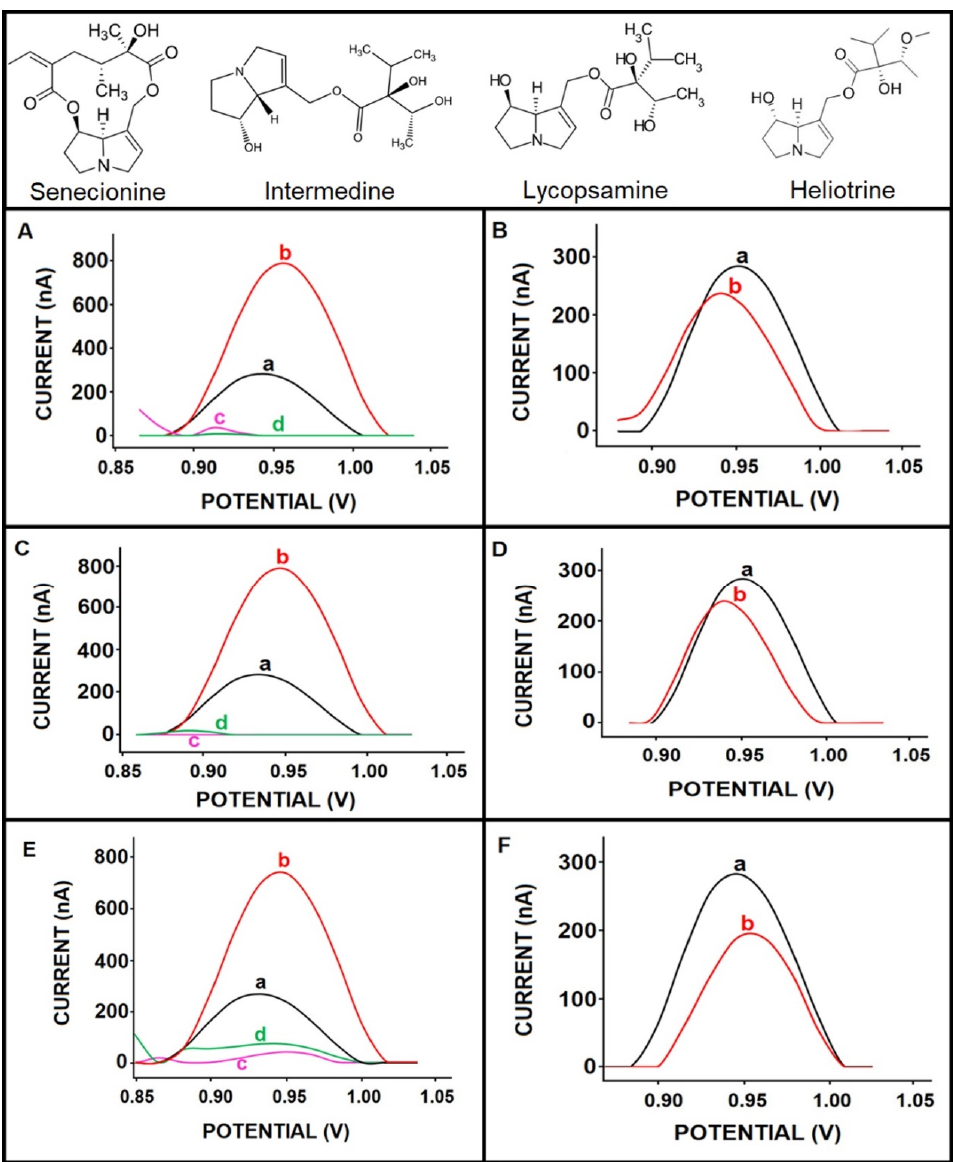
Figure 5. Voltammograms related to the selectivity of our assay in the presence of potential interferents individually ( A , C , E ) or in mixture samples ( B , D , F ) with the chemical structure of SEN and interferents. ( A ) The oxidation signal of (a) 25 µg/mL SEN, (b) 100 µg/mL SEN, (c) 25 µg/mL intermedine, (d) 100 µg/mL intermedine. ( B ) The oxidation signal of 25 µg/mL SEN (a) in the absence of intermedine and (b) in the presence of mixture sample containing 25 µg/mL SEN and 25 µg/mL intermedine. ( C ) The oxidation signal of (a) 25 µg/mL SEN, (b) 100 µg/mL SEN, (c) 25 µg/mL lycopsamine, (d) 100 µg/mL lycopsamine. ( D ) The oxidation signal of 25 µg/mL SEN (a) in the absence of lycopsamine and (b) in the presence of mixture sample containing 25 µg/mL SEN and 25 µg/mL lycopsamine. ( E ) The oxidation signal of (a) 25 µg/mL SEN, (b) 100 µg/mL SEN, (c) 25 µg/mL heliotrine, (d) 100 µg/mL heliotrine. ( F ) The oxidation signal of 25 µg/mL SEN (a) in the absence of heliotrine and (b) in the presence of mixture sample containing 25 µg/mL SEN and 25 µg/mL heliotrine.